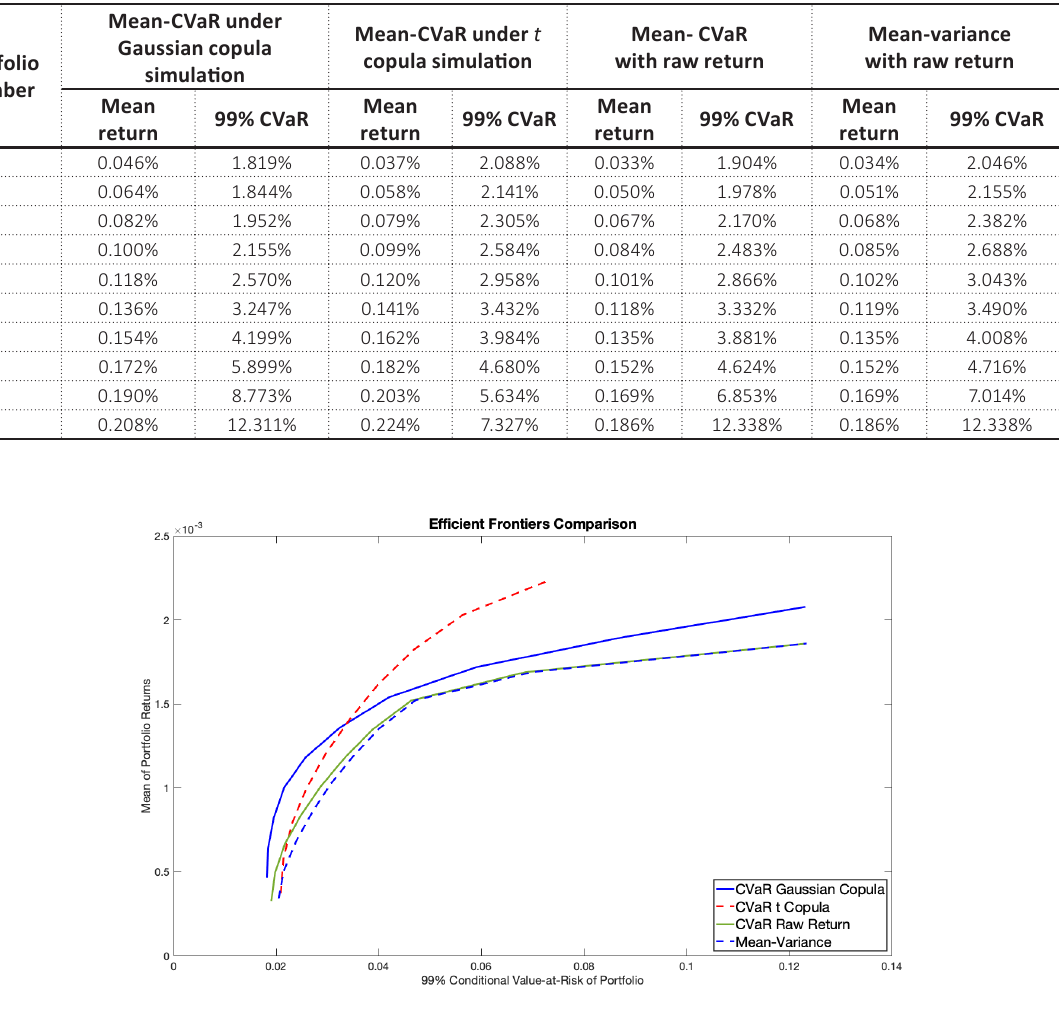
Figure 4. Mean-CVaR efficient frontiers with the 99%